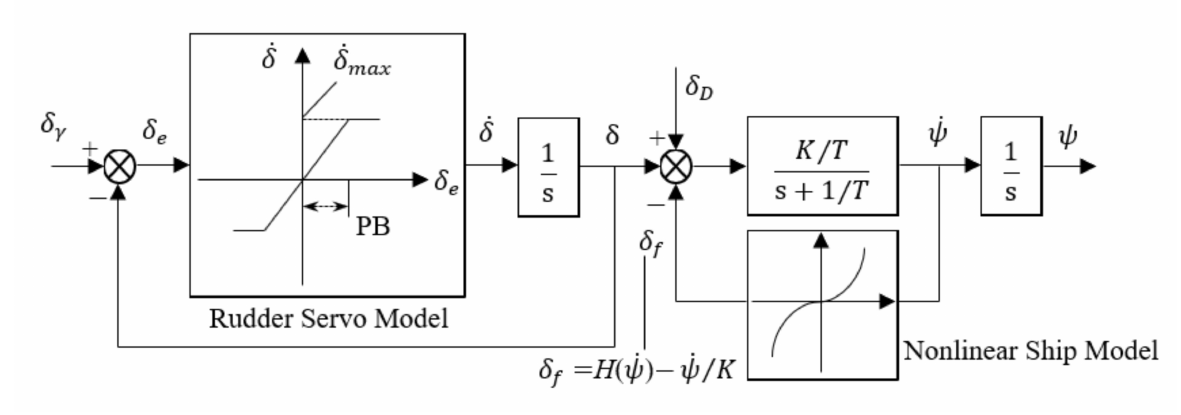
Figure 2. Responding nonlinear ship